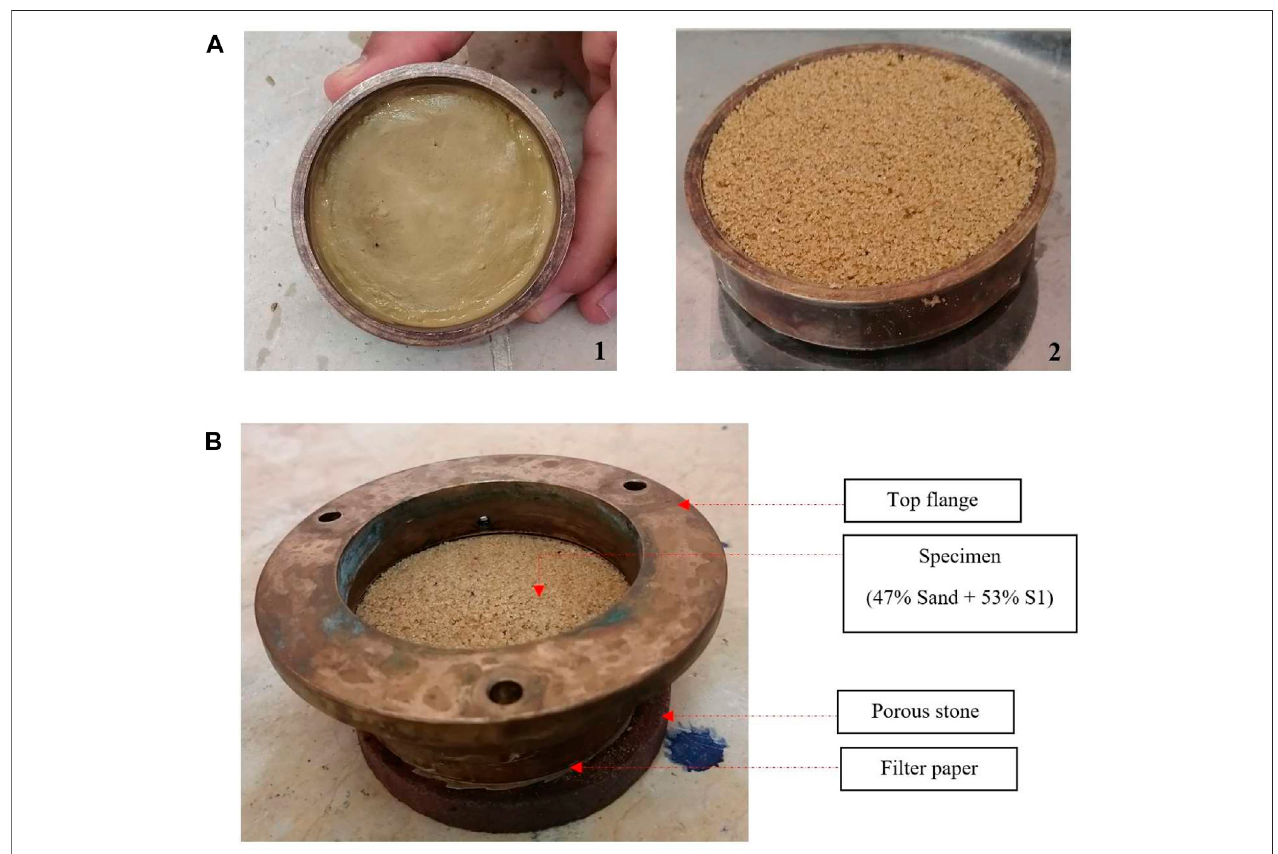
FIGURE 13 | (A) Sand and an expansive soil S1 inside the oedometer ring. (B) Case 2 specimen.